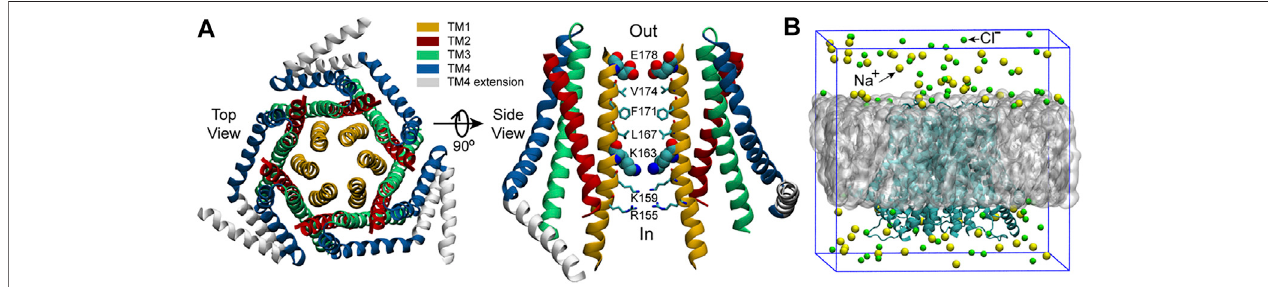
FIGURE 1 | The structure of dOrai and the initial simulation system. (A) The crystal structure of Drosophila melanogaster Orai obtained from the Protein Data Bank (PDB ID: 4HKR) (Hou et al., 2012). In the right panel, only two oppositing subunits are shown for clarity. The SF of the pore, E178, and the starting residue of the basic region, K163, are shown with the VDW representation, the other pore residues are shown with Licorice representation in VMD (visual molecular dynamics) (Humphrey et al., 1996). (B) The initial simulation system. The grey sphere represents the POPC bilayer. Water molecules are not shown here but included in the